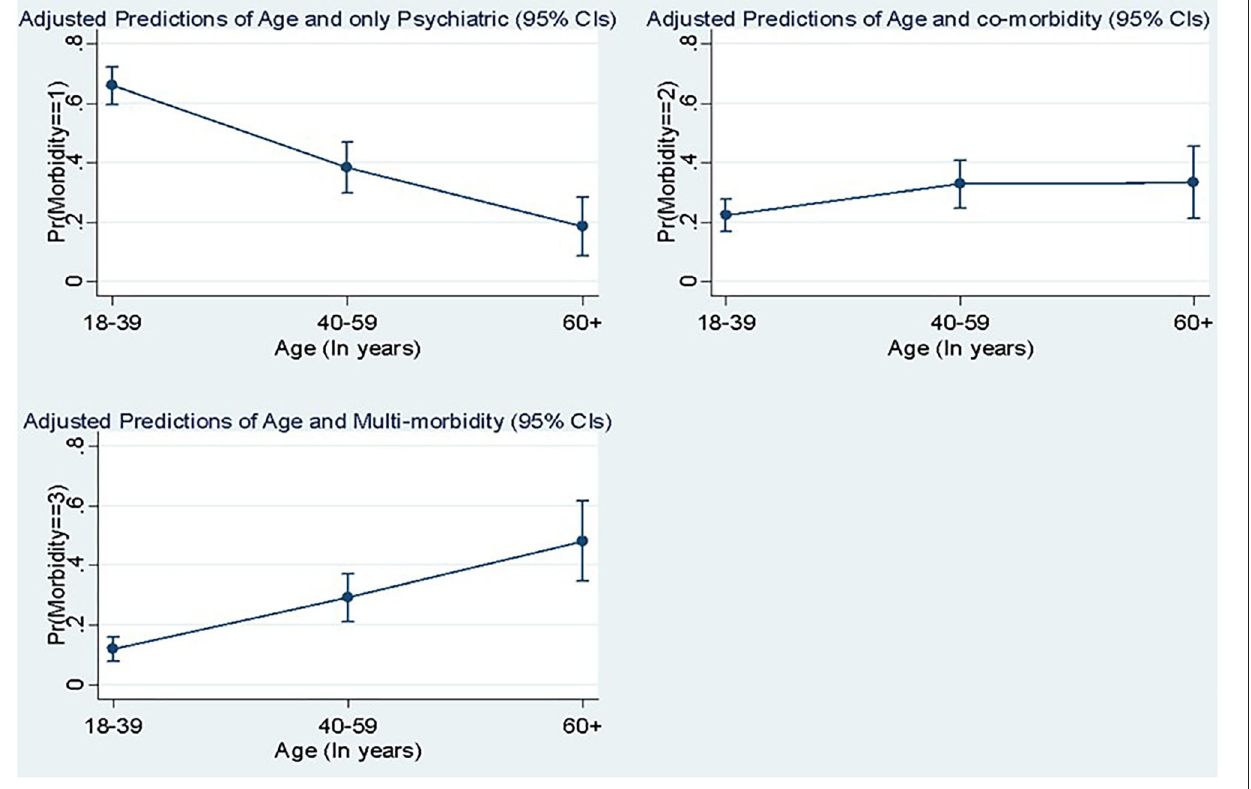
FIGURE 2 | Predicted probabilities of the number of comorbidities with age.